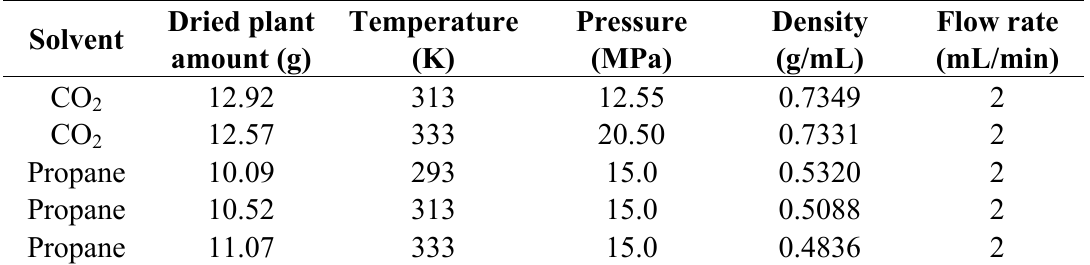
Table 4. Conditions used to produce P. amalago L. leaf extracts with supercritical CO compressed